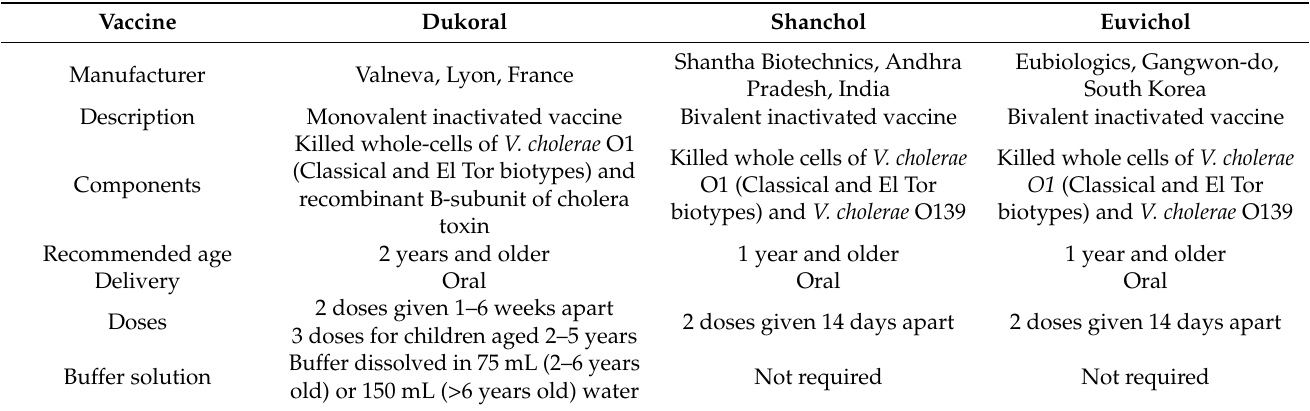
Table 1. Internationally Licensed and Recommended Inactivated Oral Cholera Vaccines